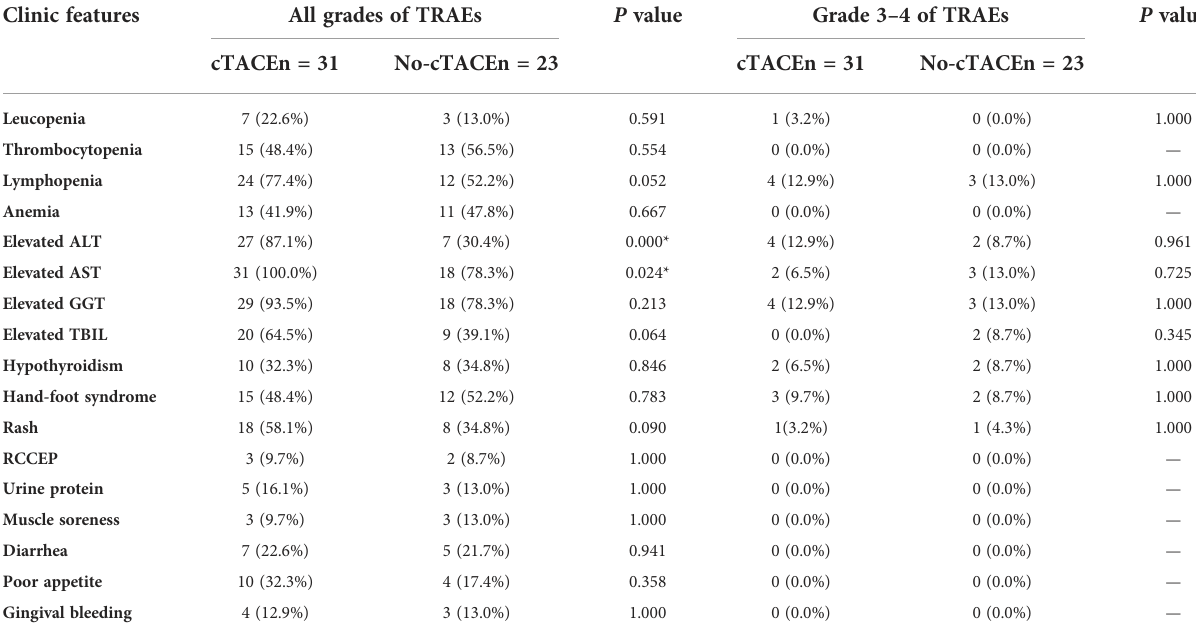
TABLE 6 TRAEs during treatment in both